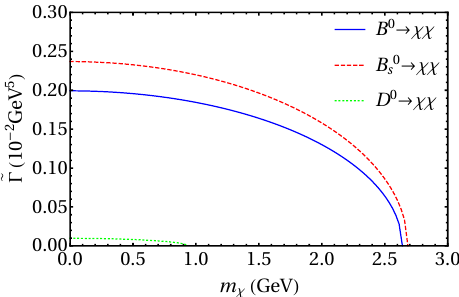
Figure 2. Meson annihilation modes.